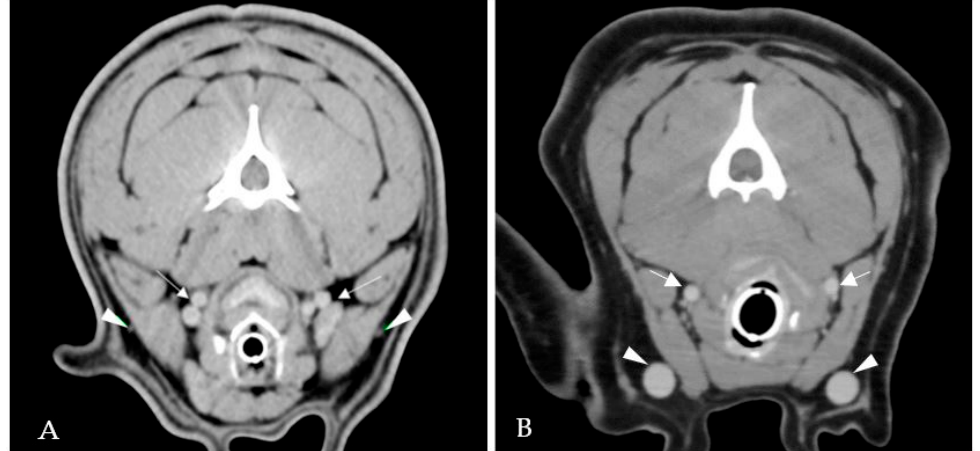
Figure 4. ECG-gated computed tomography angiography in Case 3. Severe bilateral hypoplasia of the external jugular veins (white arrowheads) with a secondary compensatory increase in the diameter of both internal jugular veins (white arrows) ( A ). ECG-gated computed tomography angiography in a dog with normal cervical venous system. External jugular veins (white arrowheads) and internal jugular veins (white arrows) ( B ).